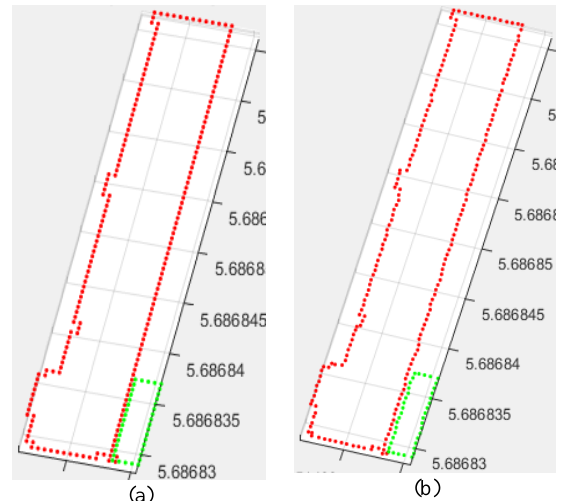
Figure 4. a) Detected edge points of the grid, b) detected